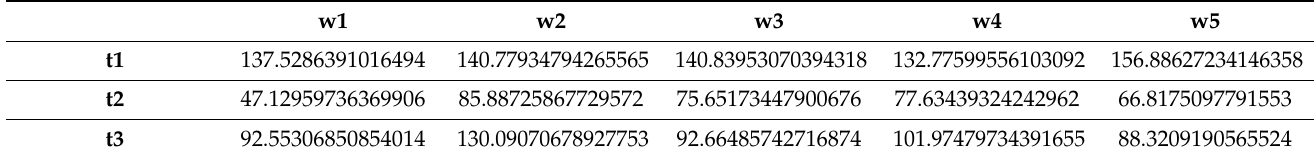
Table 2. Task execution duration (TED).